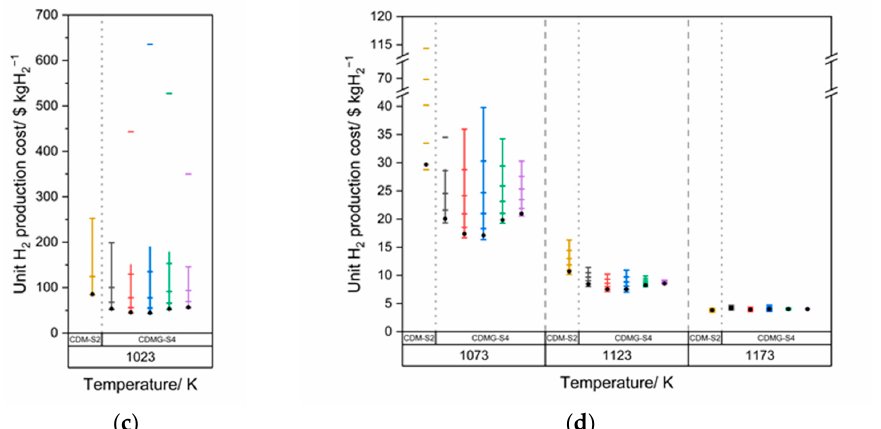
Figure 7. Unit H 2 production cost for methane pyrolysis (MP) systems of ( a ) thermal methane pyrolysis (TMP-S1), ( b ) catalytic methane pyrolysis (CMP-S2), and the systems with additional gasification and WGS reaction of ( c ) TMPG-S3 and ( d ) CMPG-S4.